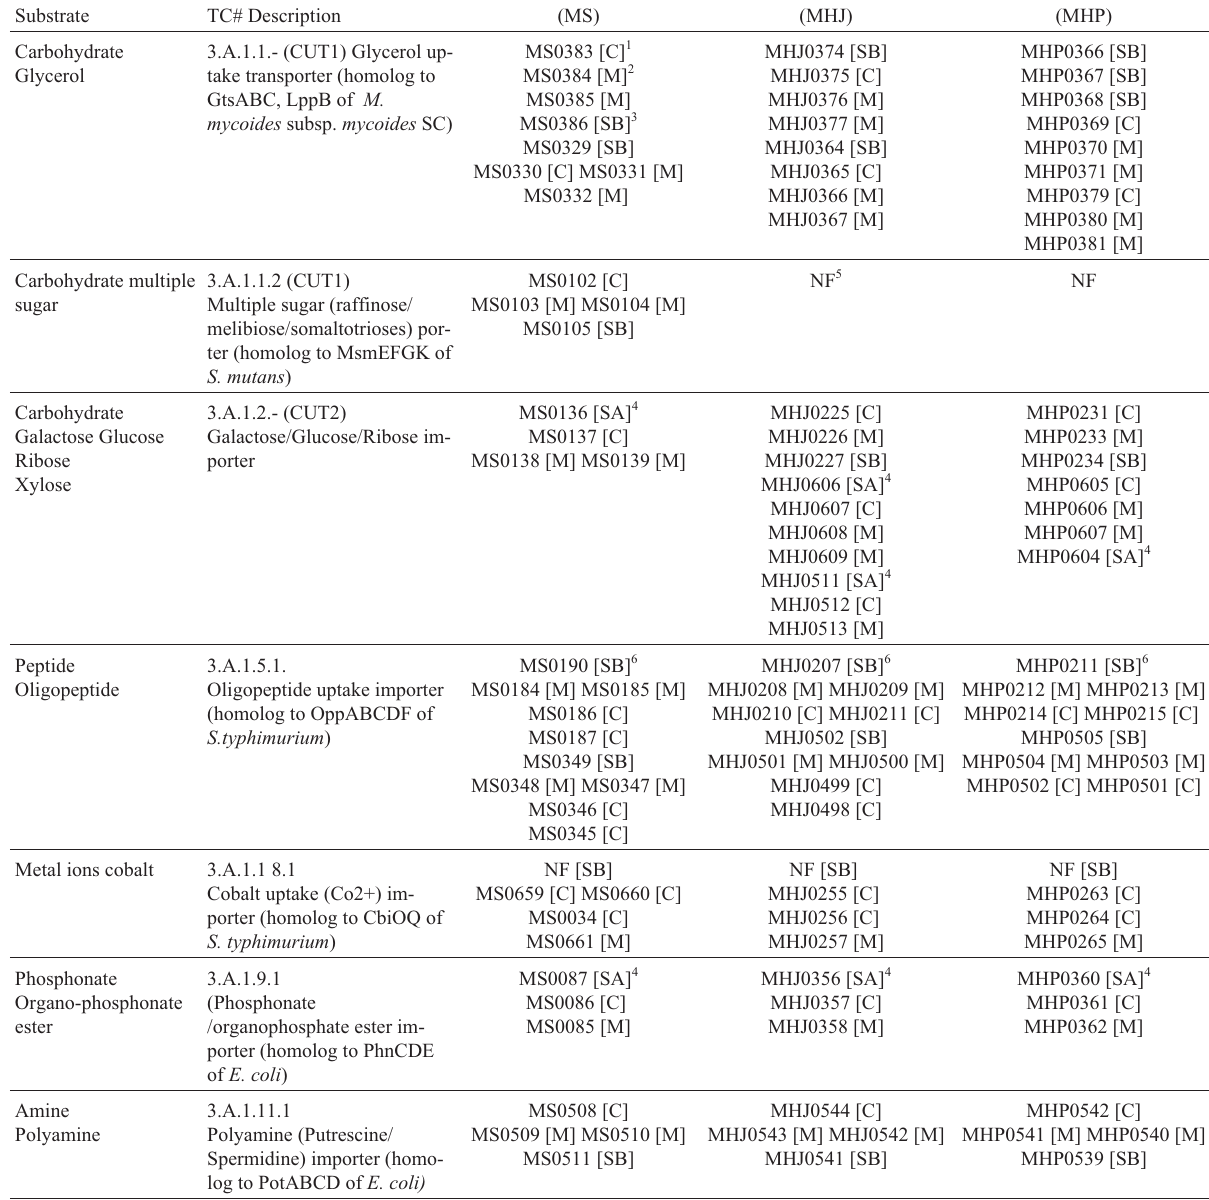
Table 2 - Description of CDSs related to ABC importers (uptake systems) in the M. synoviae strain 53 (MS) and M. hyopneumoniae strains J (MHJ) and 7448 (MHP) genomes.